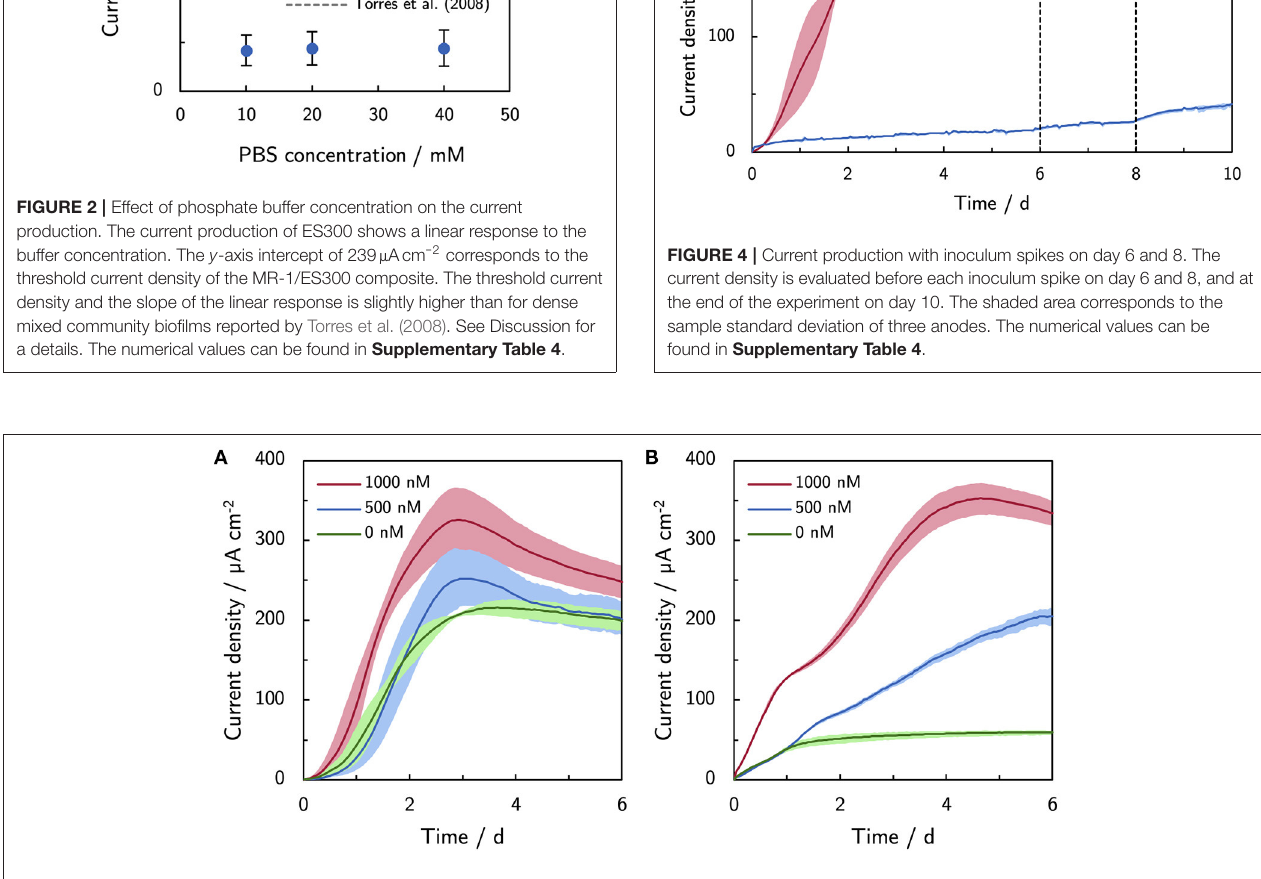
FIGURE 3 | Effect of riboflavin (500 and 1,000 nM) on the current production. (A) Current production of ES300 and (B) C-Tex 13. The shaded area corresponds to the sample standard deviation of three anodes. The numerical values of the maximum and final current densities can be found in Supplementary Table 4 .